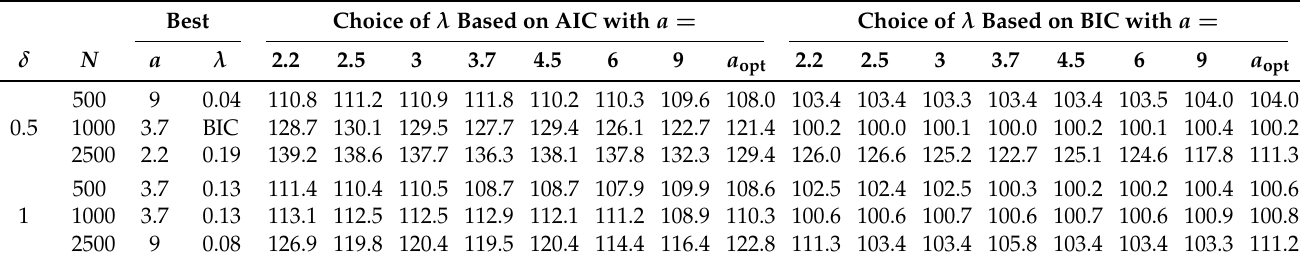
Table 3. Focused Simulation Study 1A: Relative root mean square error (RMSE) of estimated group means for unbalanced DIF effects as a function of the size of DIF effects δ and sample size N for different values a of the SCAD